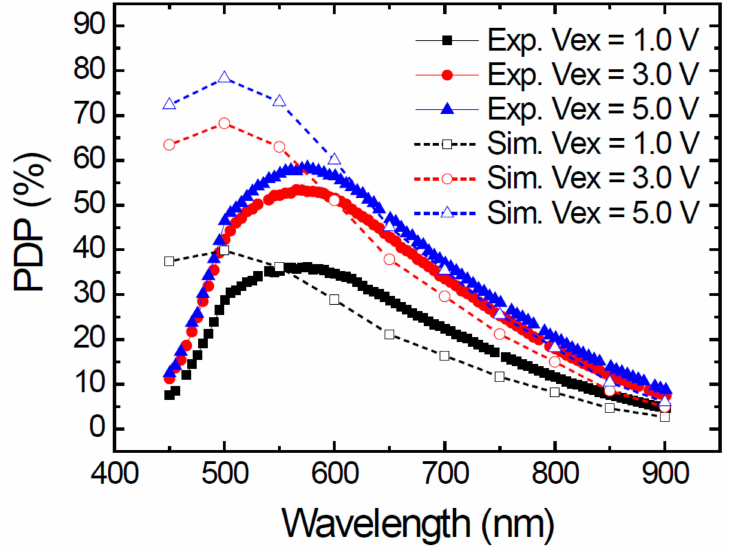
Figure 8. Experimental and simulated photon-detection probability (PDP) spectra at excess voltages Vex = 1.0, 3.0, and 5.0